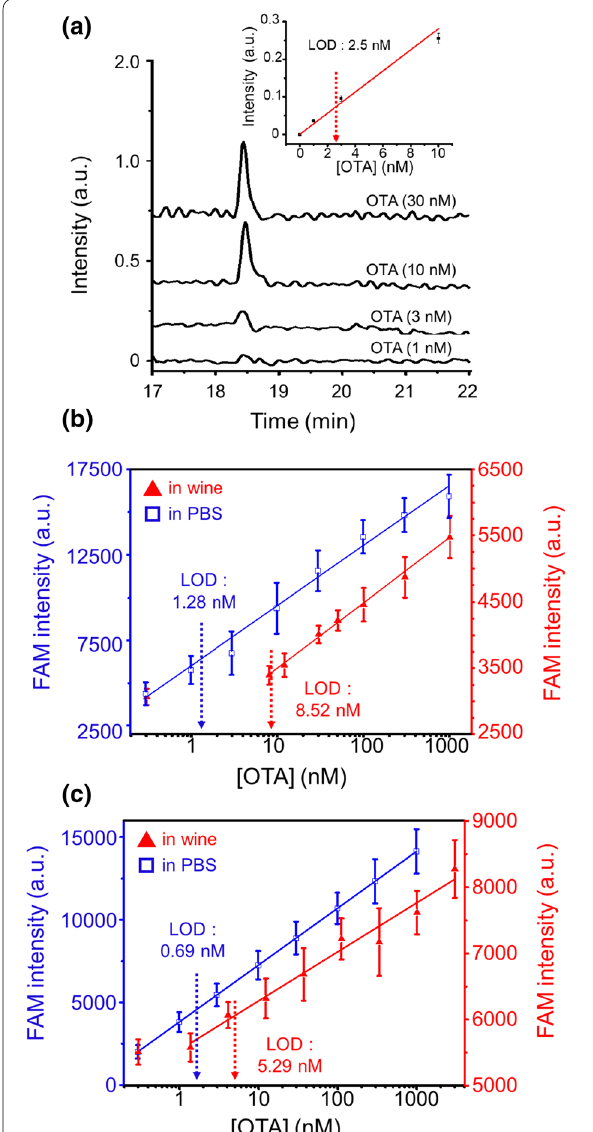
Fig. 4 Quantitative analysis of OTA‑spiked wine samples using a HPLC, b one‑step immunoassay based on liquid extraction, c one‑step immunoassay based on direct dilution, and d lateral flow immunoassay